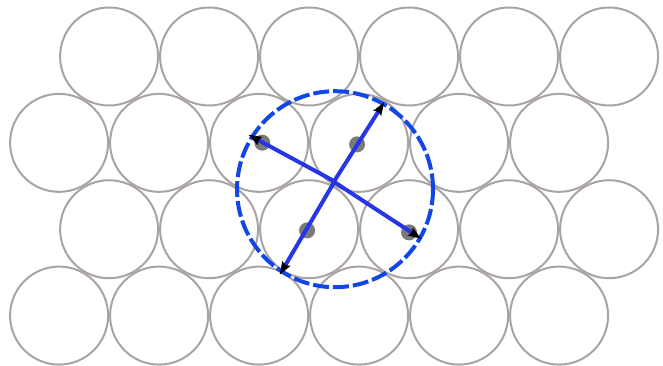
Figure 7 . A dense sphere packing (solid gray) can be used to construct a large spherical code (dashed blue) by surrounding some of the centers with an auxiliary sphere, then projecting the enclosed centers onto that